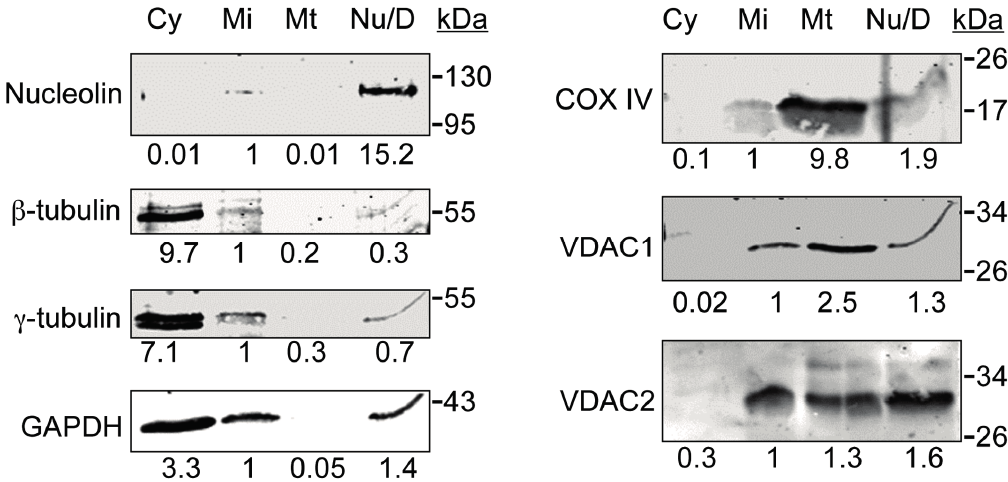
Figure 1. VDAC1 and VDAC2 are present in both mitochondrial and non-mitochondrial sub-cellular fractions. Asynchronously growing RPE1 cells were separated into cytosolic (Cy), microsomal (Mi), and mitochondrial (Mt) fractions. The pellet fraction that contained nuclei, debris and unlysed cellular components was further extracted in lysis buffer (Nu/D). Equal amounts (5 µg) of proteins from these sub-cellular fractions were separated on SDS-PAGE, transferred to nitrocellulose membrane and probed with antibodies against indicated proteins. Molecular weight standards (kDa) are shown next to the immunoblots. The numbers below each immunoblot represent the ratio of background-corrected intensities in each sub-cellular fraction to that in the microsomal fraction for the corresponding